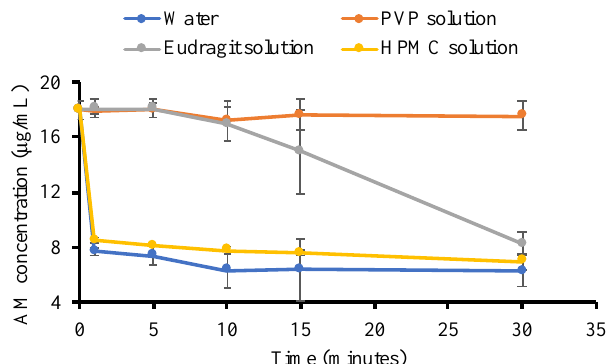
Figure 6. The concentration of AM in the water and each polymer solution for 30 min ( n = 3, mean ± standard deviation).